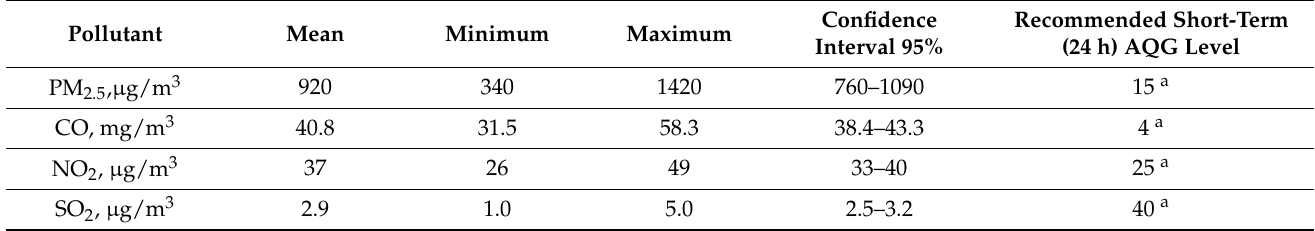
Table 1. The content of some combustion products in the air of the exposure